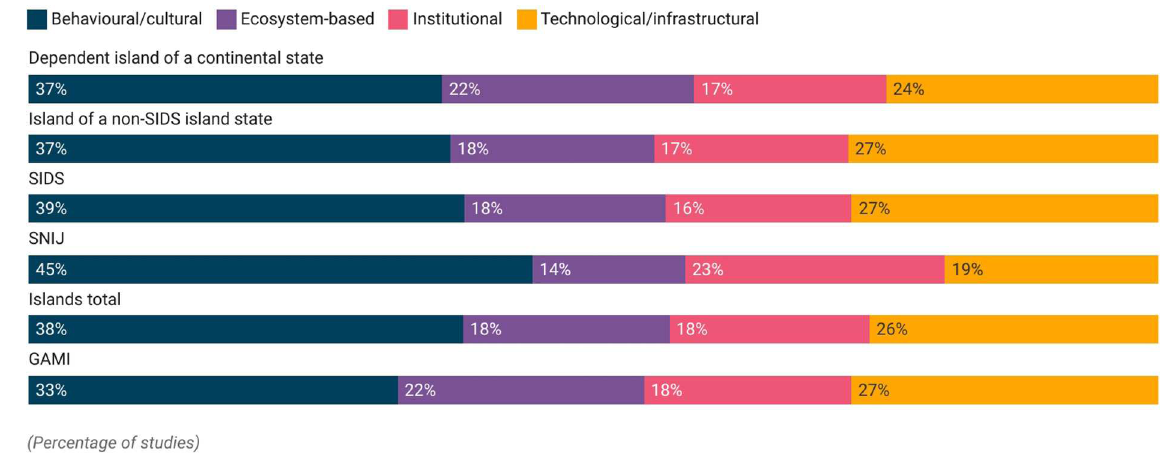
FIGURE7 Distribution of response types reported in island case studies compared to the whole GAMI